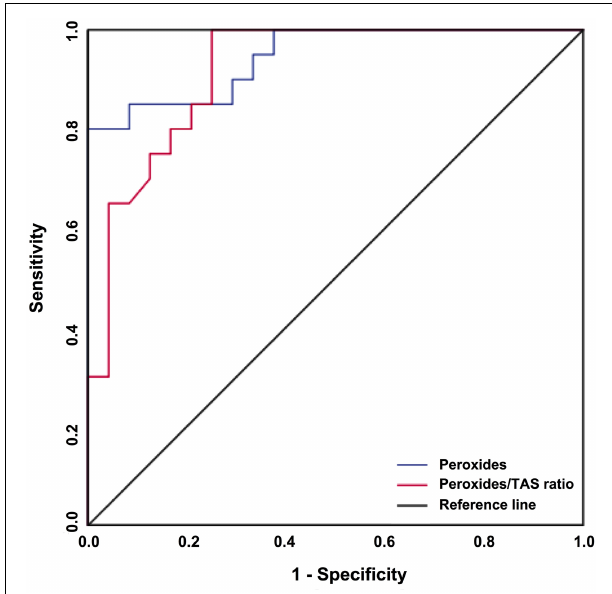
FIGURE 3 | The predictive value of peroxides and peroxides/TAS ratio regarding ESA treatment responses in MDS patients. A ROC curve analysis for peroxides and peroxides/TAS ratio was performed to assess its potential as a biomarker of ESA treatment